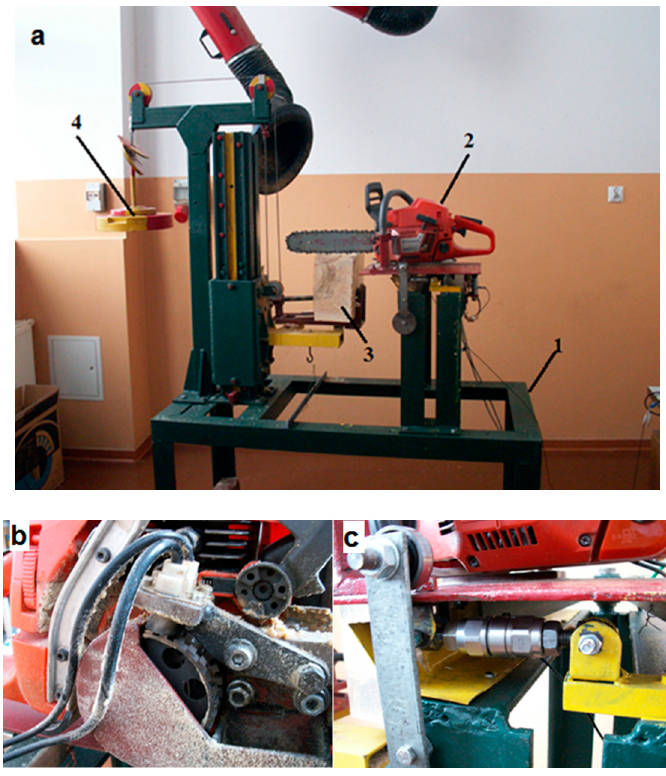
Figure 2. Real view of experimental stand for measuring chainsaw cutting parameters (( a )—general view, cutting force sensor, ( b )—sensor measuring crankshaft and clutch drum rotational speed, ( c )—feed force sensor, 1—base, 2—chainsaw, 3—wood sample, 4—weight).